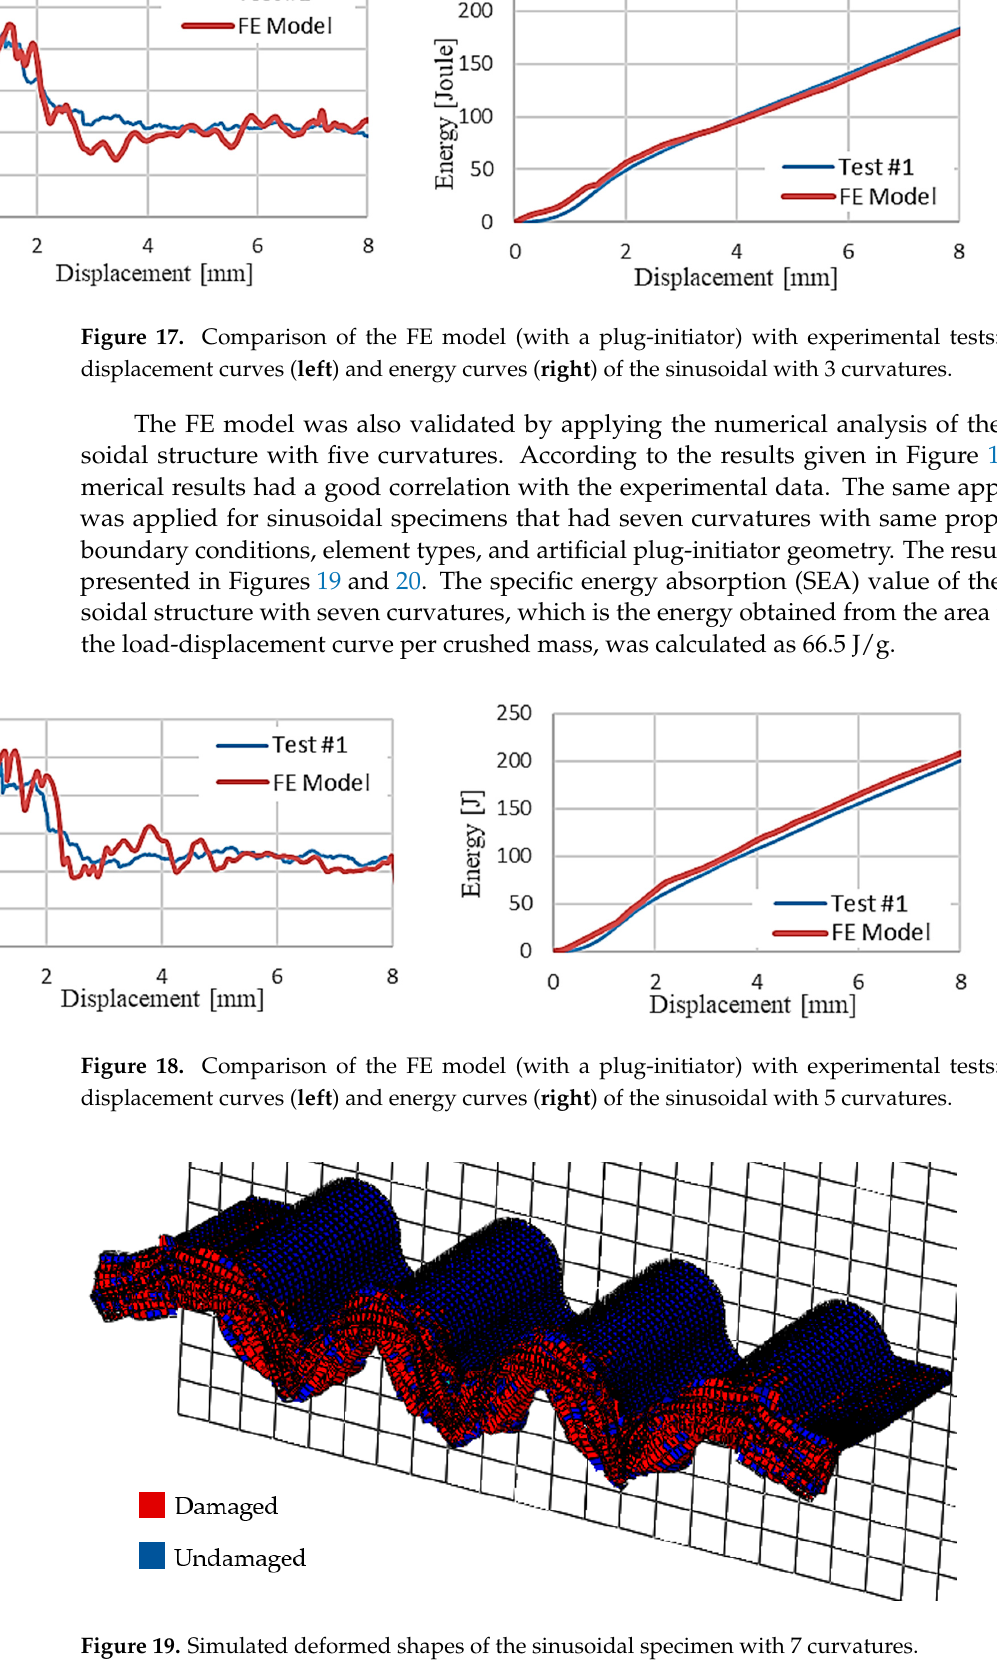
Figure 20. Simulation results of the sinusoidal structure with 7 curvatures: load-displacement curve ( left ) and energy curve ( right ). Figure 21 shows the overall comparison of SEA values for various geometries, and it can be seen that the sinusoidal structure with five curvatures had the highest energy ab- sorption capability. Beyond that structure, the performance related to energy absorption started to decrease as the number of curvatures increased. The reason behind this obser- vation can be explained by the decrease in the aspect ratio. By decreasing the diameter of the curvatures below a certain level to increase the number of curvatures, specimen ge- ometry converges into the flat-plate shape when its low width-to-length ratio is taken into consideration. Therefore, more instabilities occurred, and the energy absorption perfor- mance did not become better than the five-curvature specimen.